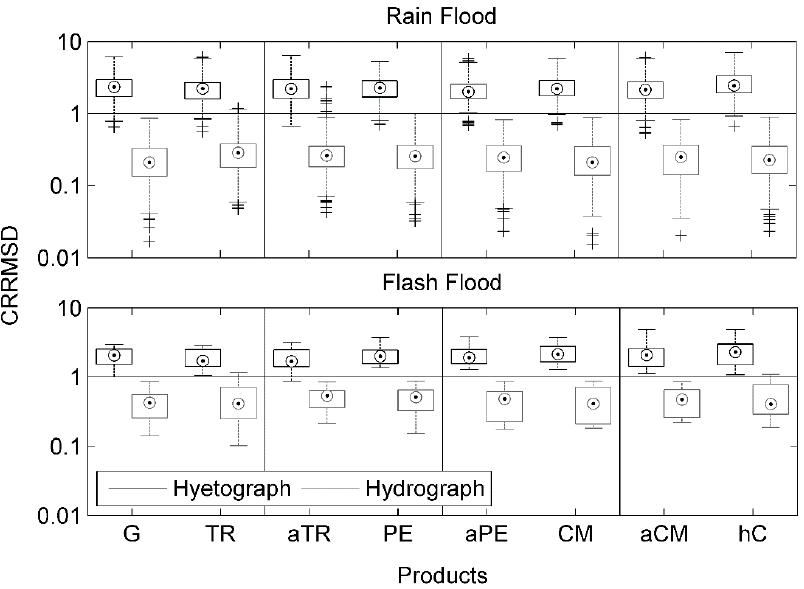
Figure 6. Boxplots of the centered relative root mean square difference. Cross corresponds to outlier and circles represent median.